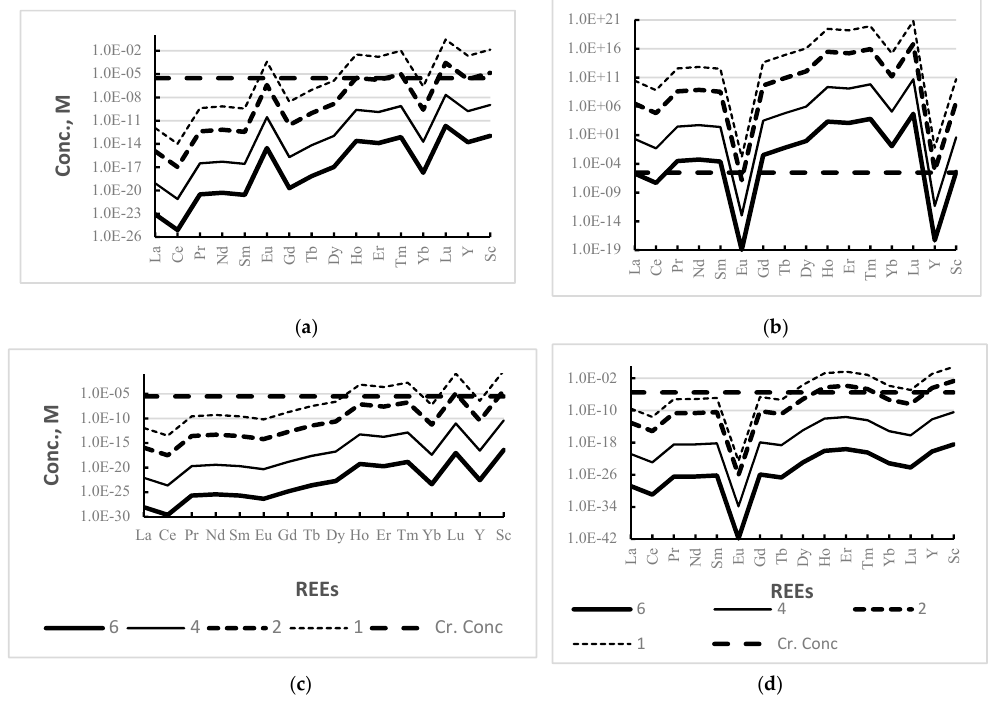
Figure 3. Concentrations of ( a ) Re 3+ , ( b ) ReCl 2+ , ( c ) Re(NO 3 ) 2+ , and ( d ) Re(SO 4 ) 2 − in equilibrium with phosphate precipitate with 10 − 4 M of total concentration of phosphate in solution at pH 6, 4, 2, and 1. Cr. Concentration: 1 ppm line as a target concentration.